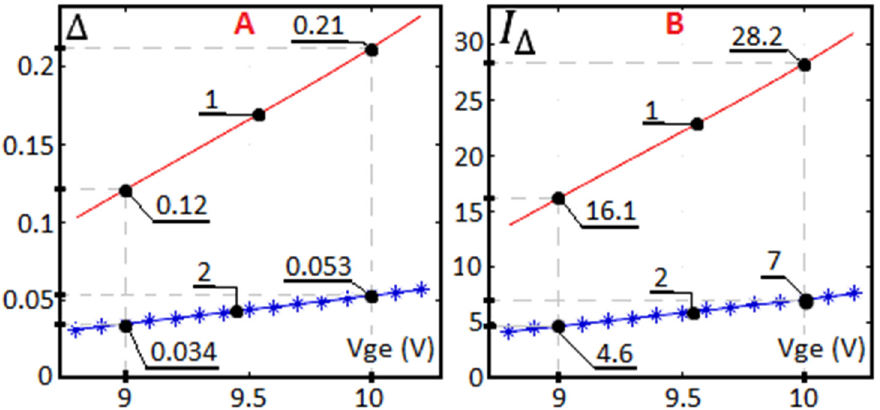
Figure 5. ( A ) Expected variation in the derating factor; ( B ) expected variation in the maximum current through the paralleled transistors. Graphics 1 and 2 at maximum and minimum thermal difference.